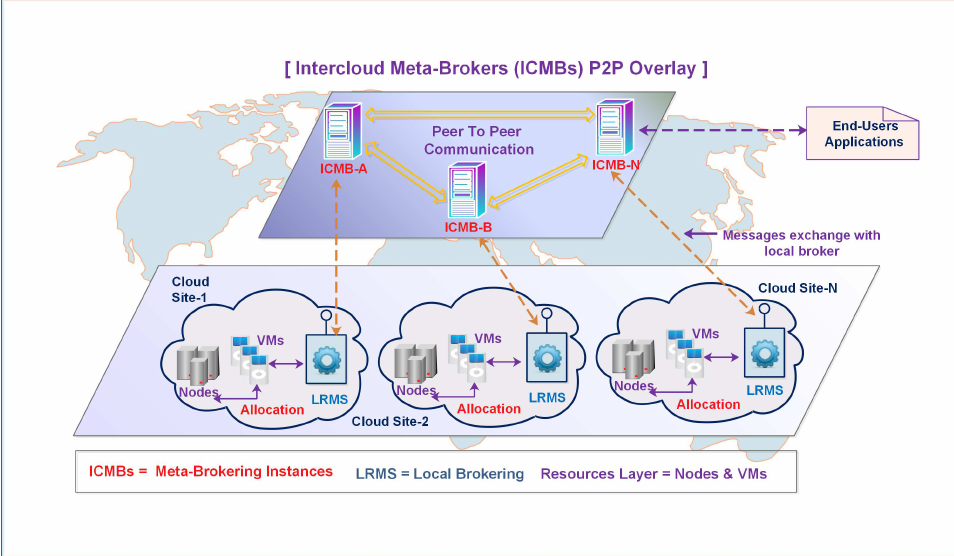
Figure 2. Global view of meta-brokering overlay for federation configuration.